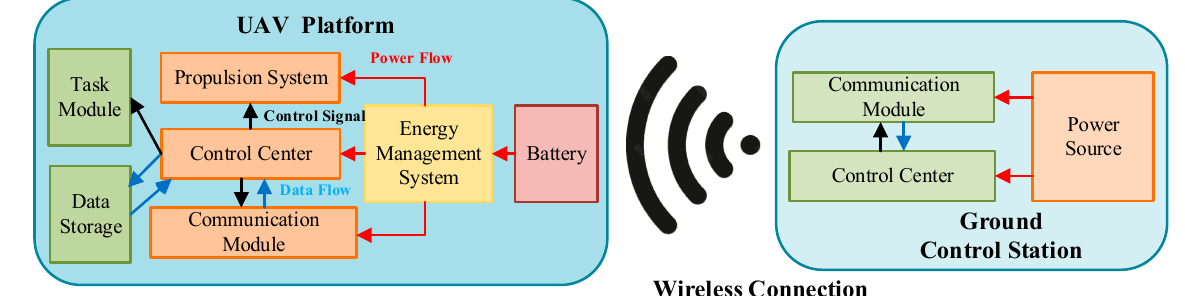
Figure 4. Unmanned aircraft system composition.